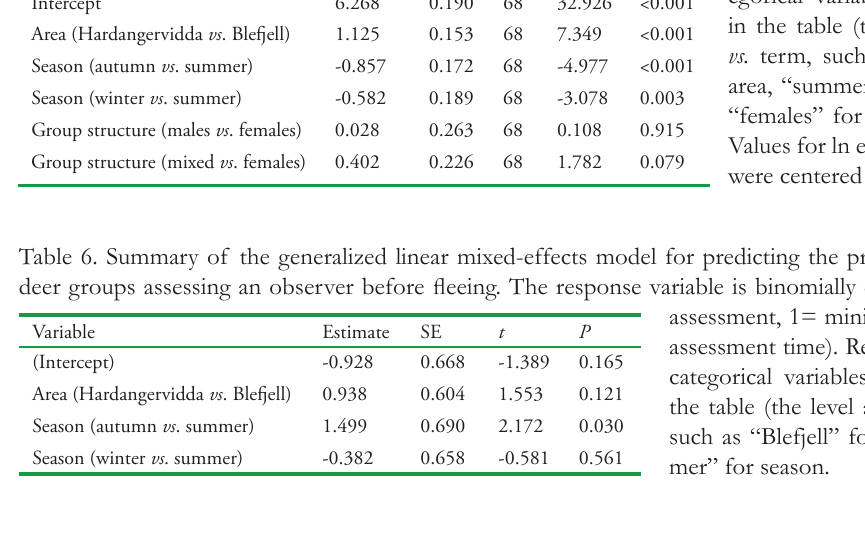
during three periods in 2004- 2006. Reference levels for cat-